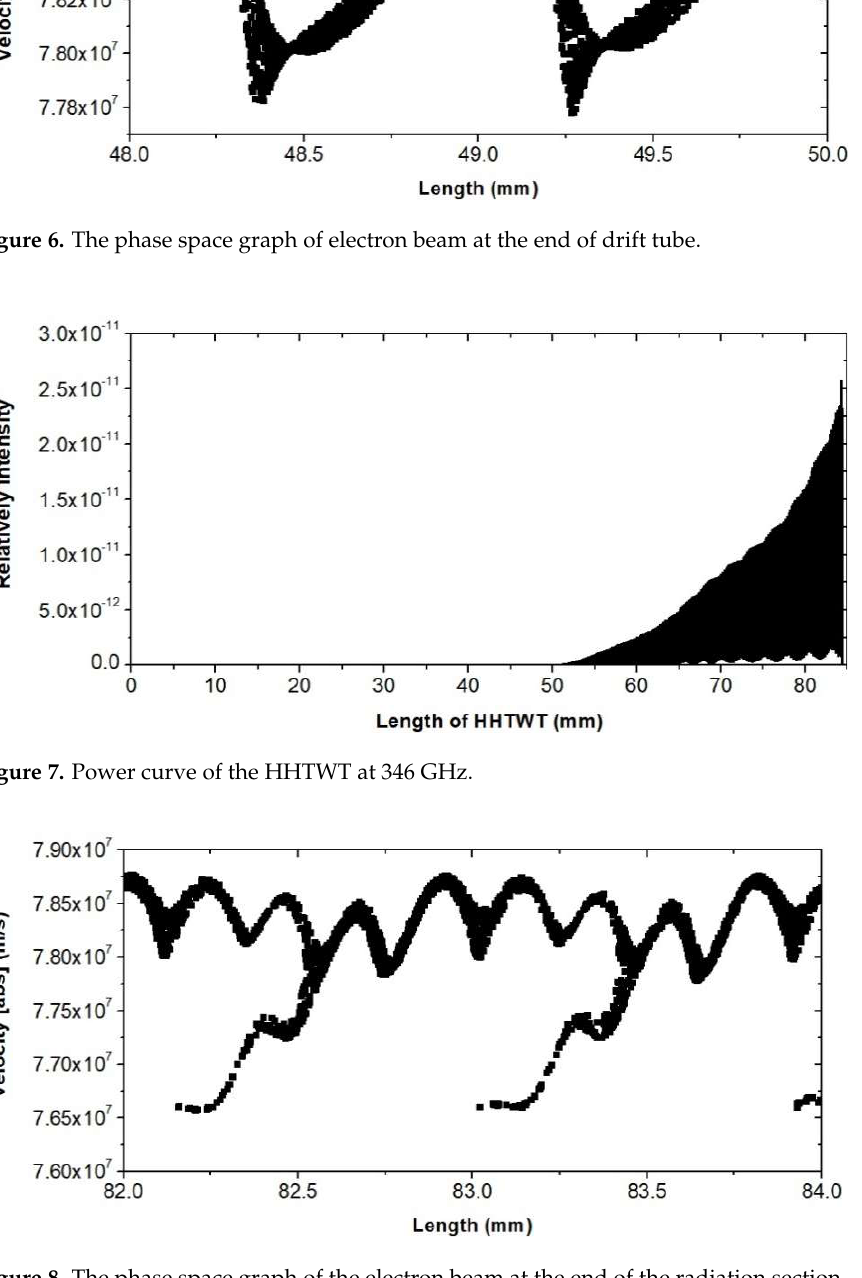
Figure 8. The phase space graph of the electron beam at the end of the radiation section.